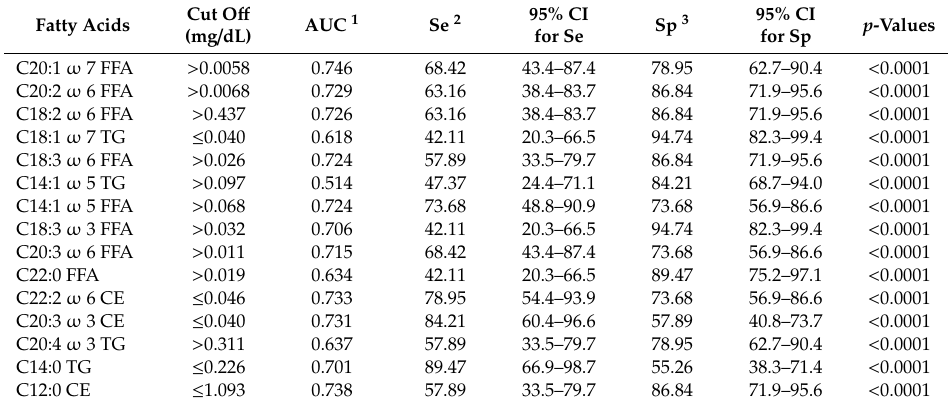
Table 9. Results related to the ROC of the predictive fatty acids for the development of hyperketonemia (Class BHB